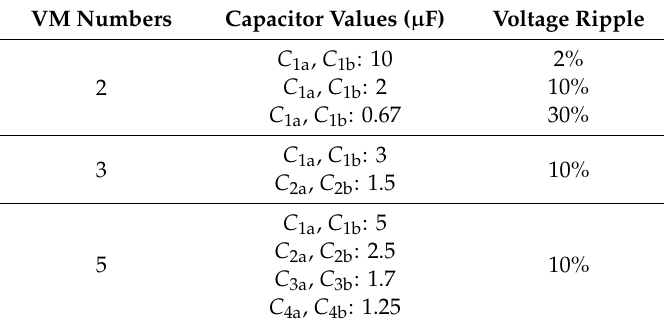
Table 4. Parameters of Capacitor Values with Different VM Numbers.